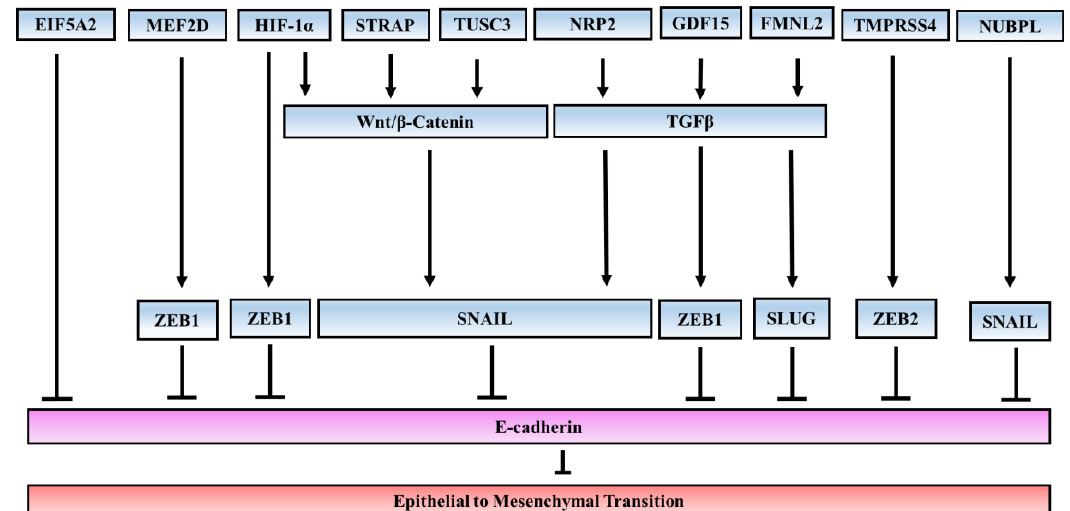
Figure 1. Crosstalk network of novel EMT inducers. Several inducers of EMT in CRC have been identified. These inducers were found to directly regulate expression of EMT-transcriptional factors or do so through other oncogenic signaling pathways. Myocyte enhancer factor 2D (MEF2D), hypoxia-inducible factor 1 alpha (HIF-1α), and transmembrane protease/serine 4 (TMPRSS4) can promote EMT by inducing expression of ZEB transcriptional factors, whereas nucleotide binding protein‐like (NUBPL) can upregulate SNAIL. Other proteins such as serine–threonine kinase receptor-associated protein (STRAP) and TUCS3 can induce the WNT/β-Catenin signaling pathway, which has been found to be involved in EMT in CRC. Additionally, neuropilin-2 (NRP2), growth differentiation factor 15 (GDF15), and formin-like2 (FMNL2) can promote TGF-β signaling and induce EMT. Overexpression of eukaryotic initiation factor 5A2 (EIF5A2) can promote EMT through an unknown mechanism which may involve C-Myc and metastasis-associated protein 1 (MTA-1). Transmembrane Protease/Serine 4 (TMPRSS4) TMPRSS4 is a member of the type II transmembrane serine protease (TTSP) family and it is